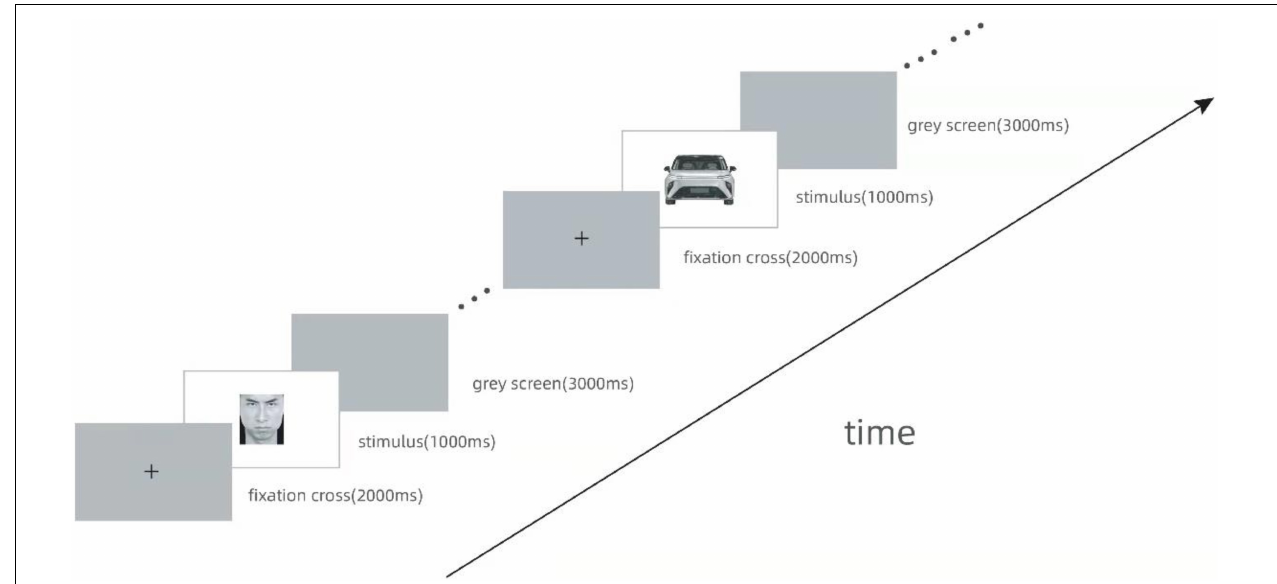
FIGURE 3 | Procedure of the experiment.